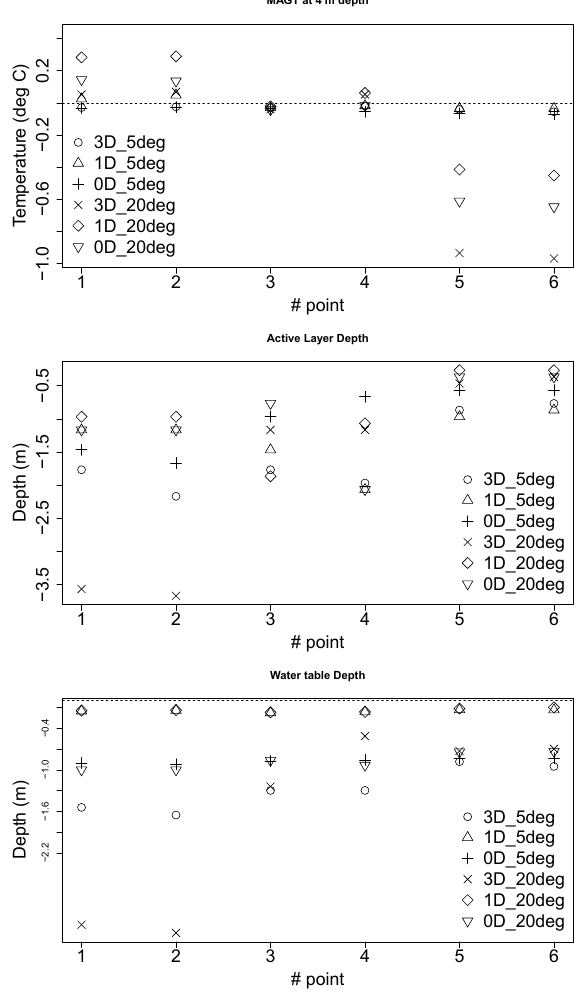
Figure 5. Mean annual ground temperature at a depth of 4m, active layer depth, and water table depth for the six points shown in Fig. 4 given by the six simulations that have been performed.